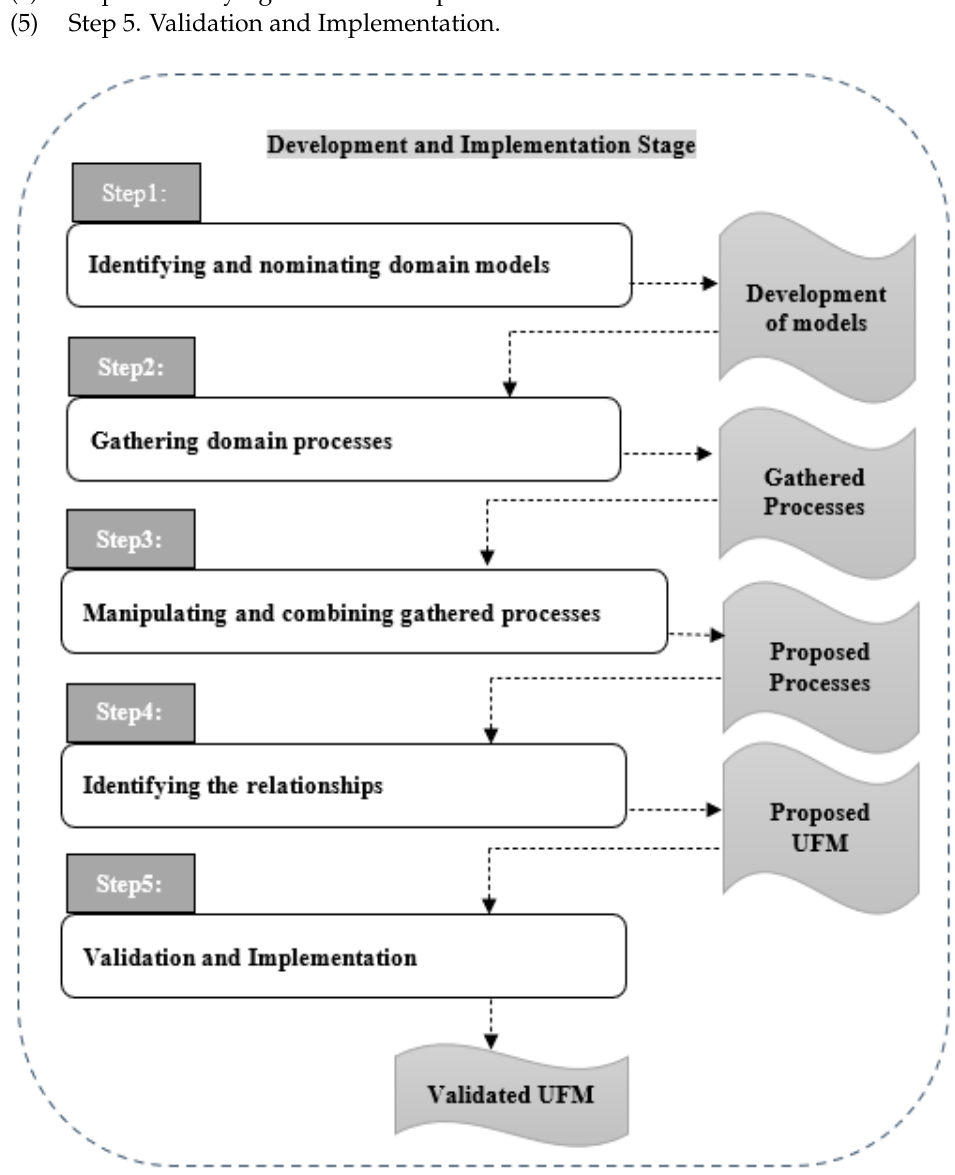
Figure 2. The design science research method.